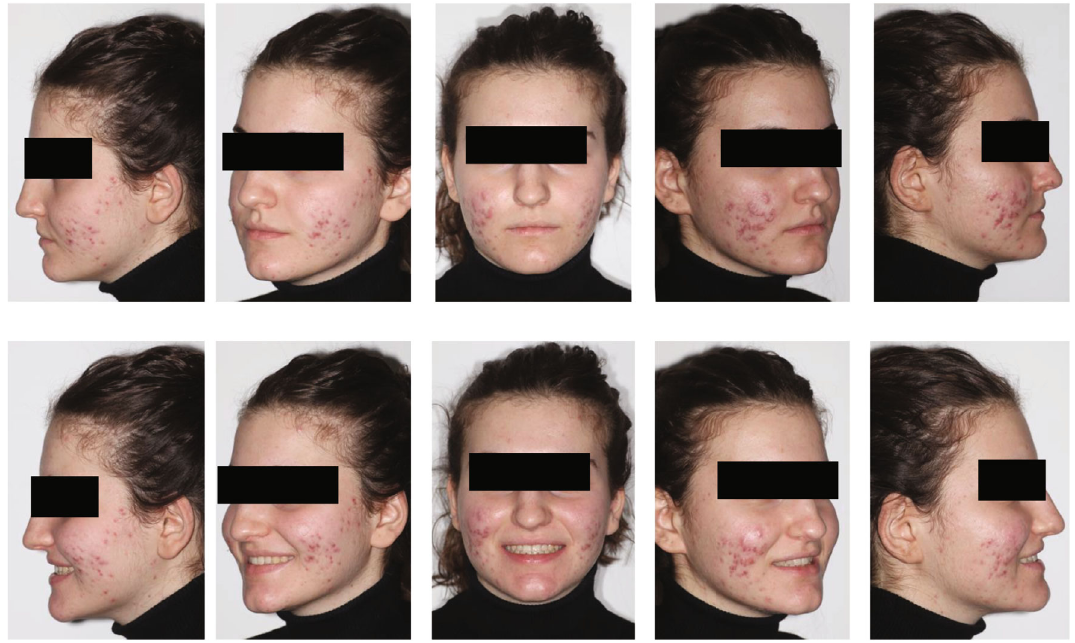
Figure 13: Final extraoral